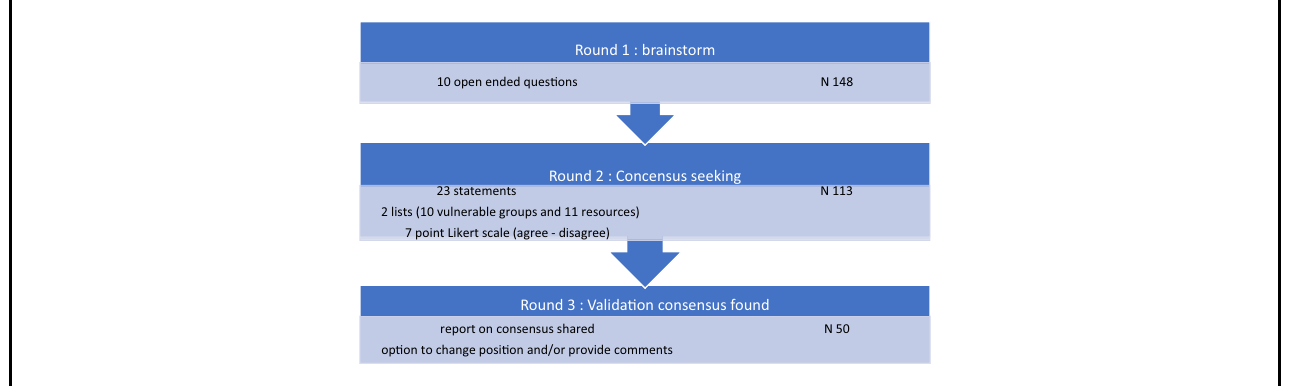
Round 3 : Valida(cid:2)on consensus found report on consensus shared